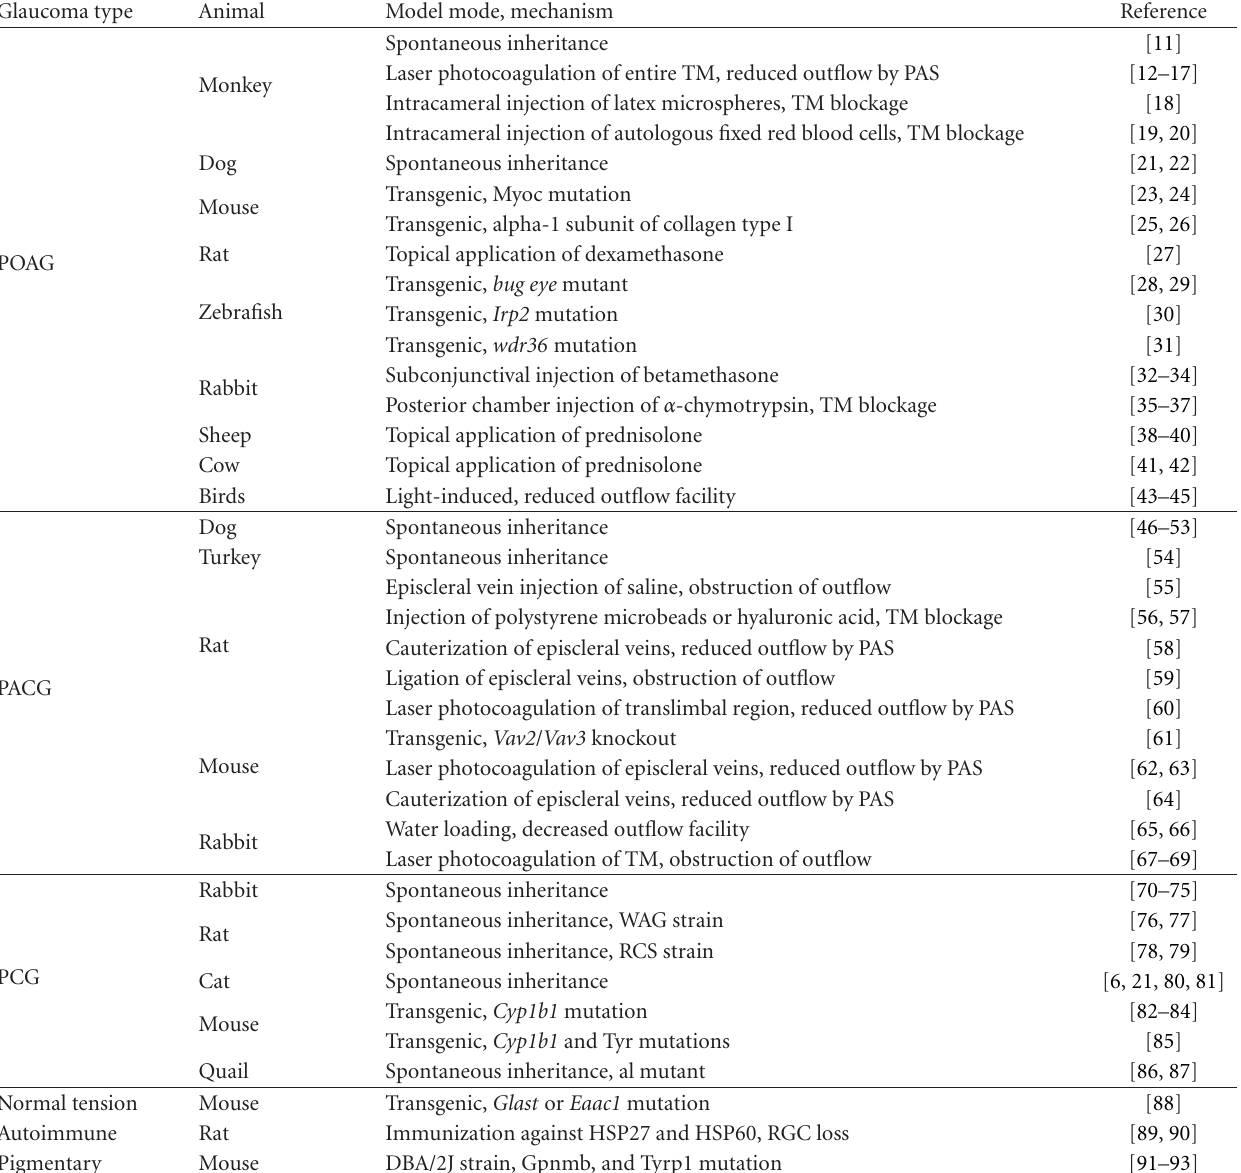
Table 1: Summary of the animal models commonly used for glaucoma